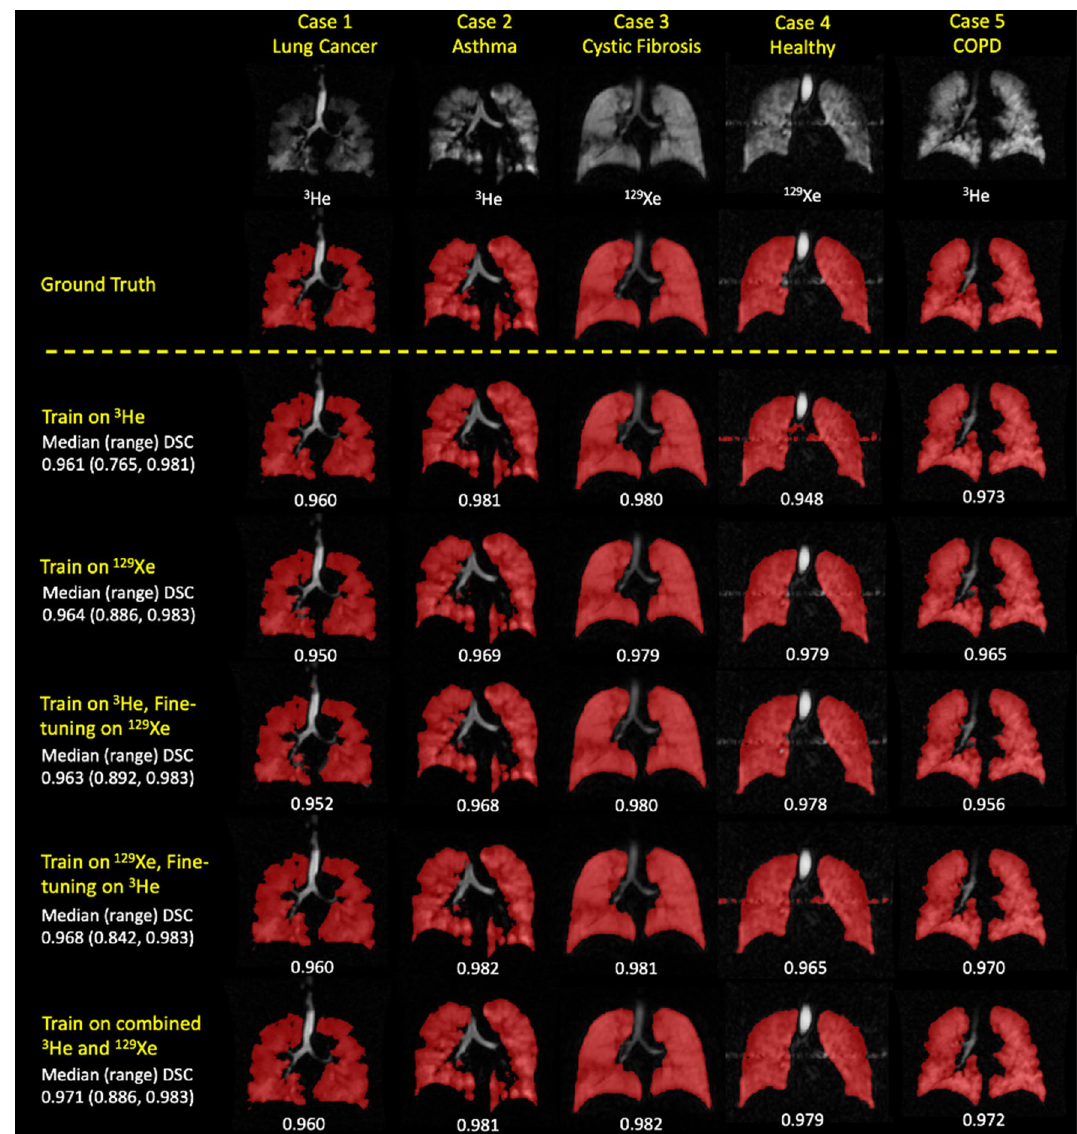
Figure 2. Example coronal slices for a healthy subject and four cases with different pathologies for each DL experimental method. Individual, and median (range), DSC values are